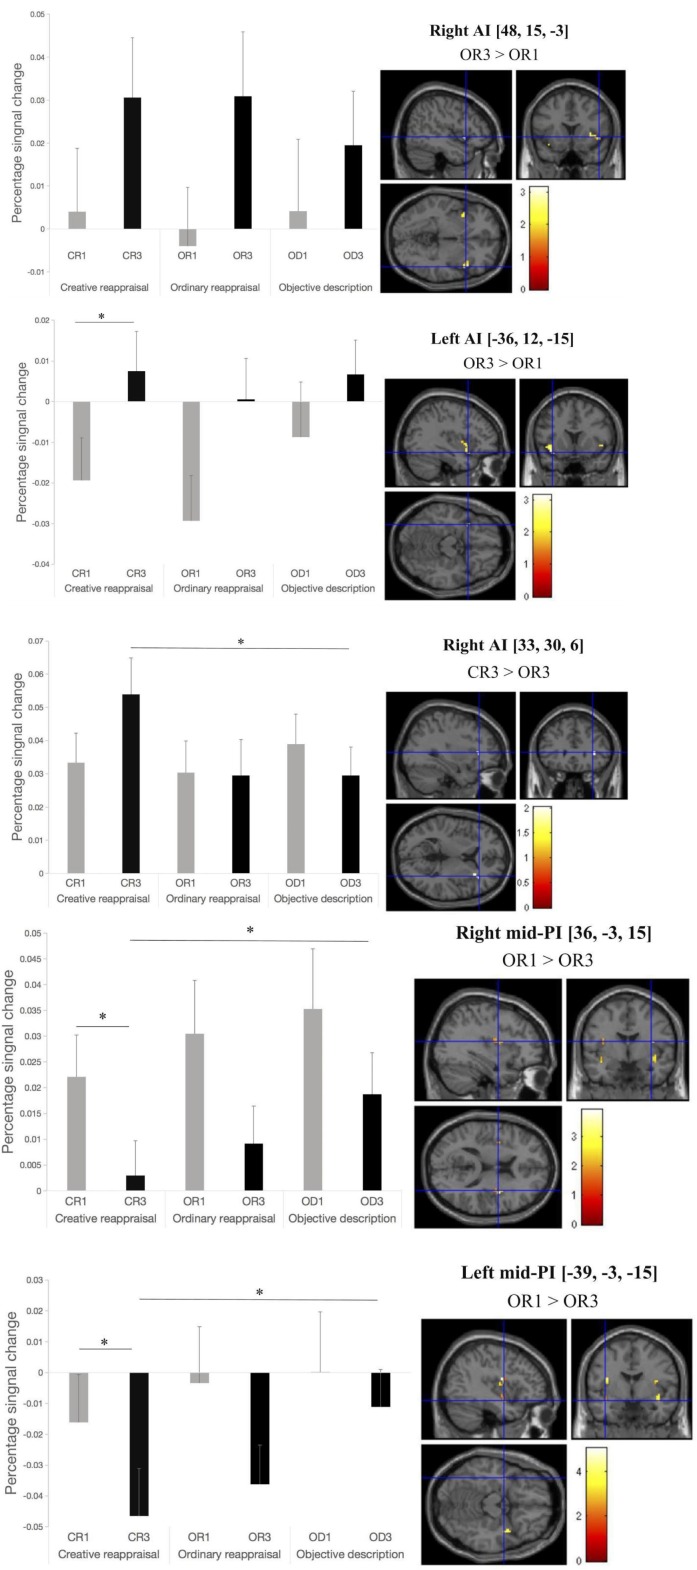
Activation in mid-posterior and anterior insular ROIs before and after the application of cognitive reappraisal or objective descriptions. Note that all the differences that reached a significant level were marked as ∗ (p < 0.05) or ∗∗ (p < 0.001) except for the contrast based on which we defined the ROIs. The location of the peak voxel in the given ROI and the contrast based on which we defined the ROIs were provided on the right top of each picture.